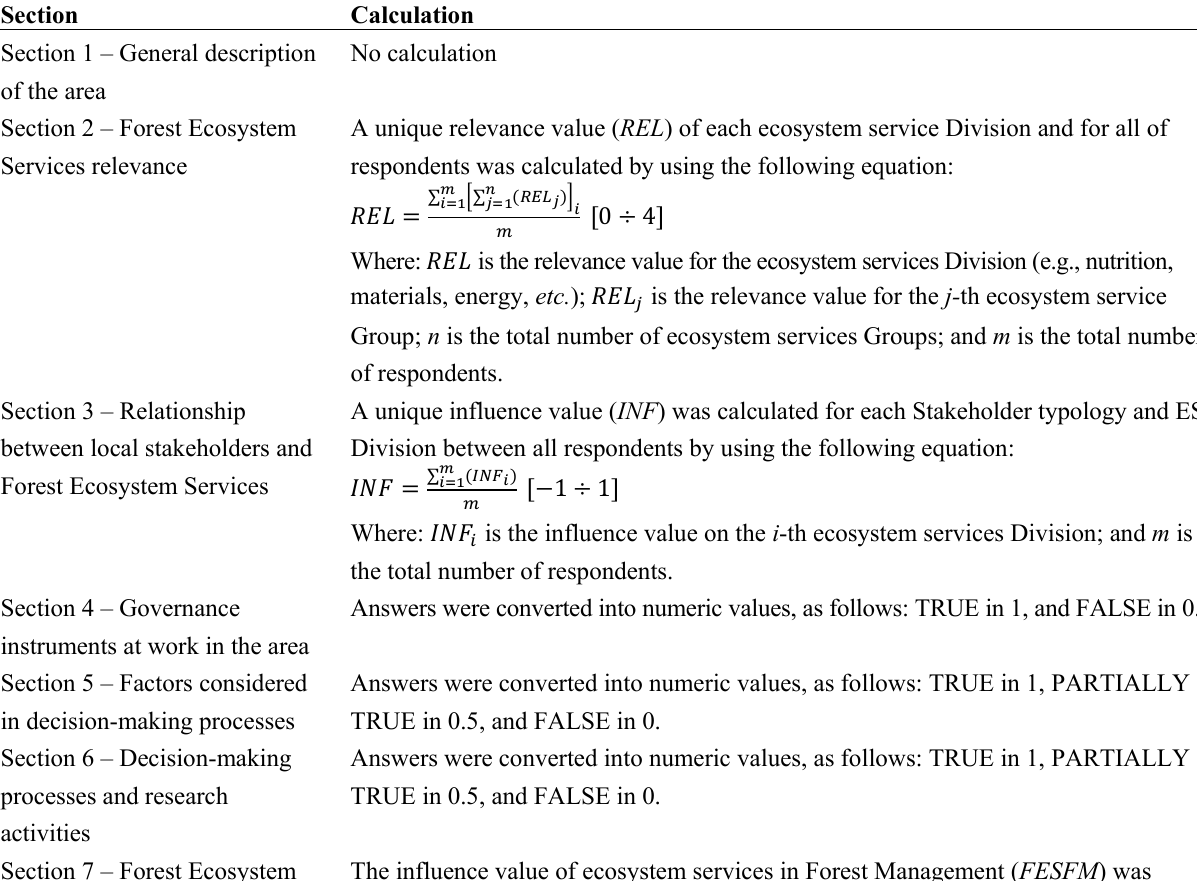
Table 2. Calculation made for each questionnaire